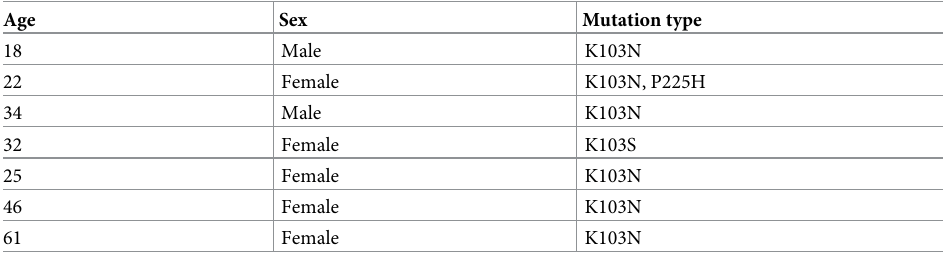
Table 4. HIV drug resistance among respondents classified as recently infected with HIV, South Africa, 2017.